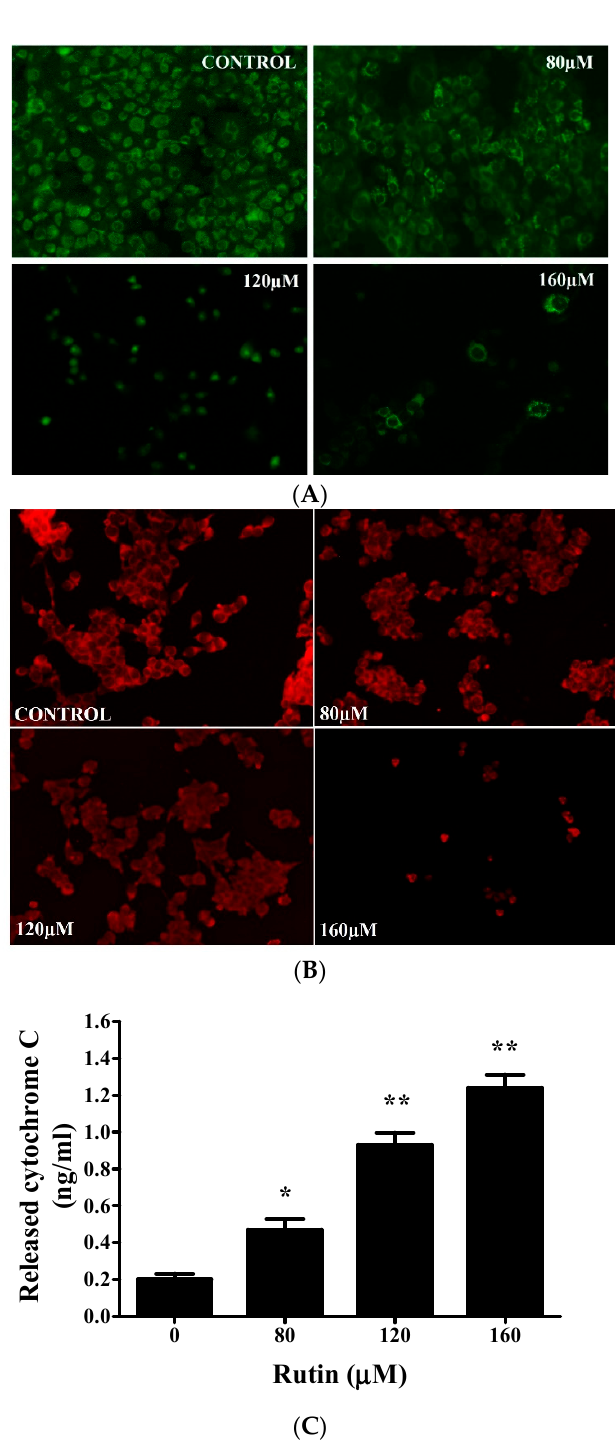
Figure 4. Rutin significantly induces mitochondrial-mediated apoptosis in cervical cancer cells. ( A ) Rutin-induced mitochondrial membrane potential (MMP) disruption in cervical cancer SiHa cells analyzed by staining with fluorescent dye Rh123 and ( B ) MitoTracker Red. ( C ) Rutin induces the release of cytochrome c in cervical cancer SiHa cells assessed by a human cytochrome c enzyme-linked immunosorbent assay kit. The results are represented as mean ± SEM of three independent experiments (* p < 0.01, ** p < 0.001 compared with control group).